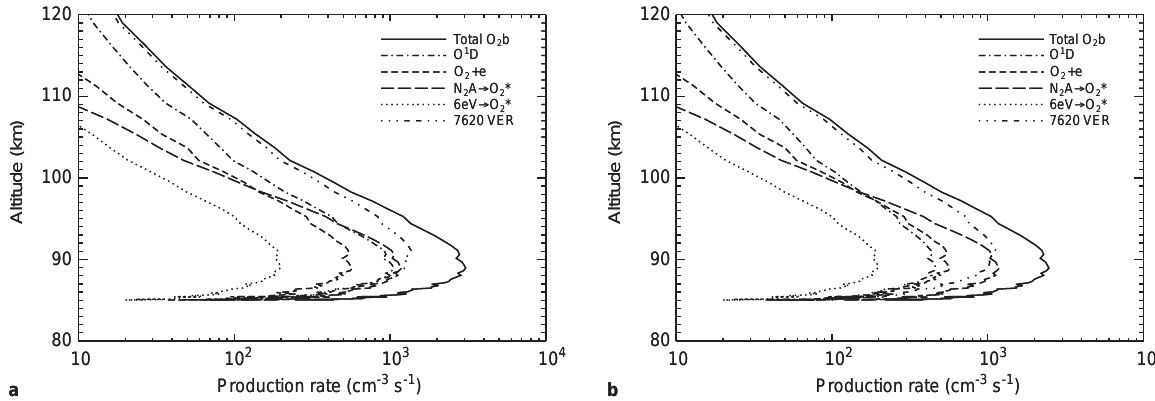
Fig. 3. a O 2 (cid:133) b 1 R (cid:135) (cid:134) production rates from various sources with normal [NO] and a 50 keV monoenergetic electron spectrum. The resultant g 7620 A˚ volume emission rate (VER) is also given. b Same as a but with high [NO]